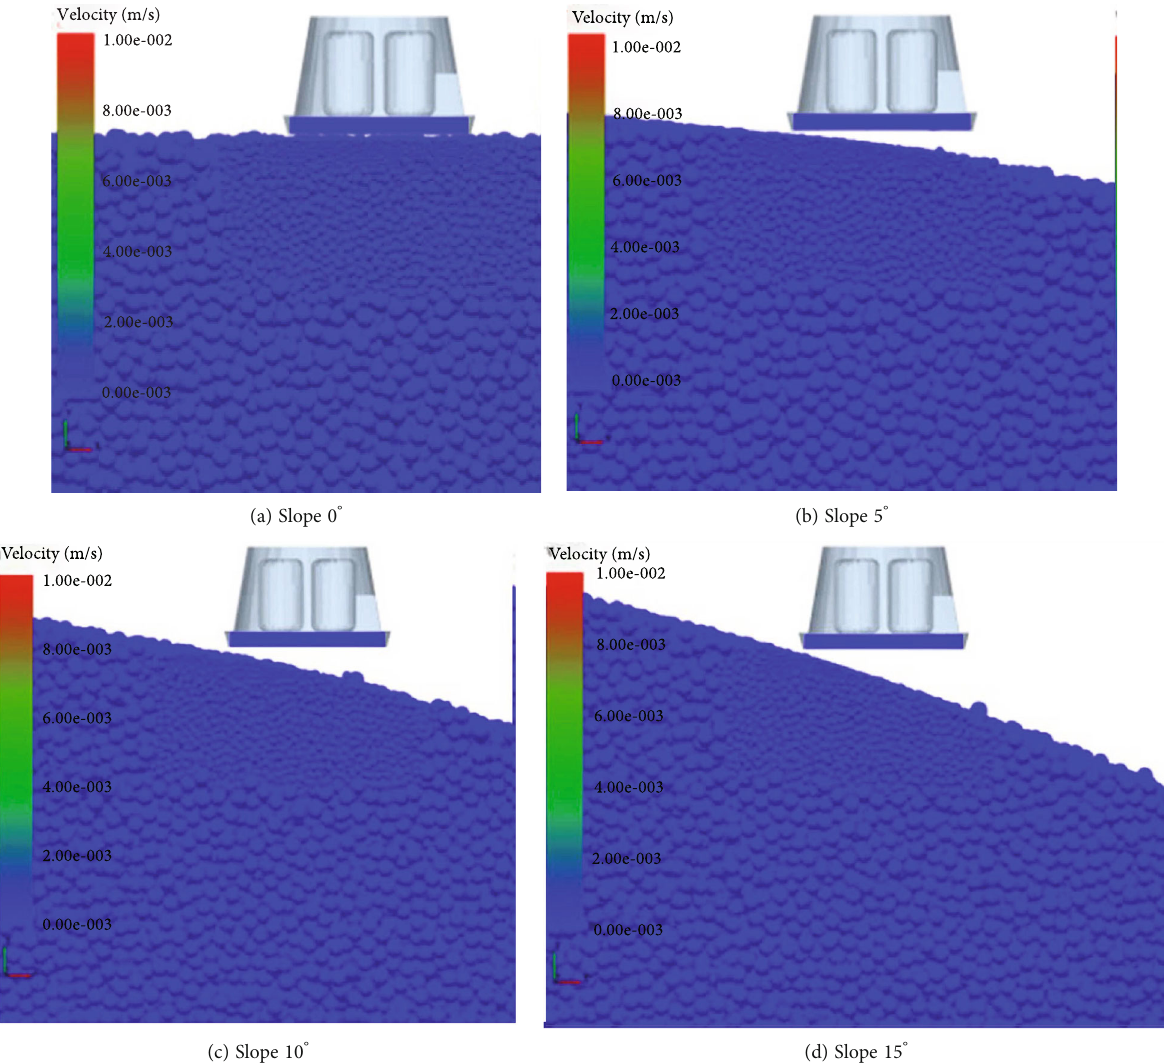
Figure 21: Schematic diagram of landing models under di ff erent slope